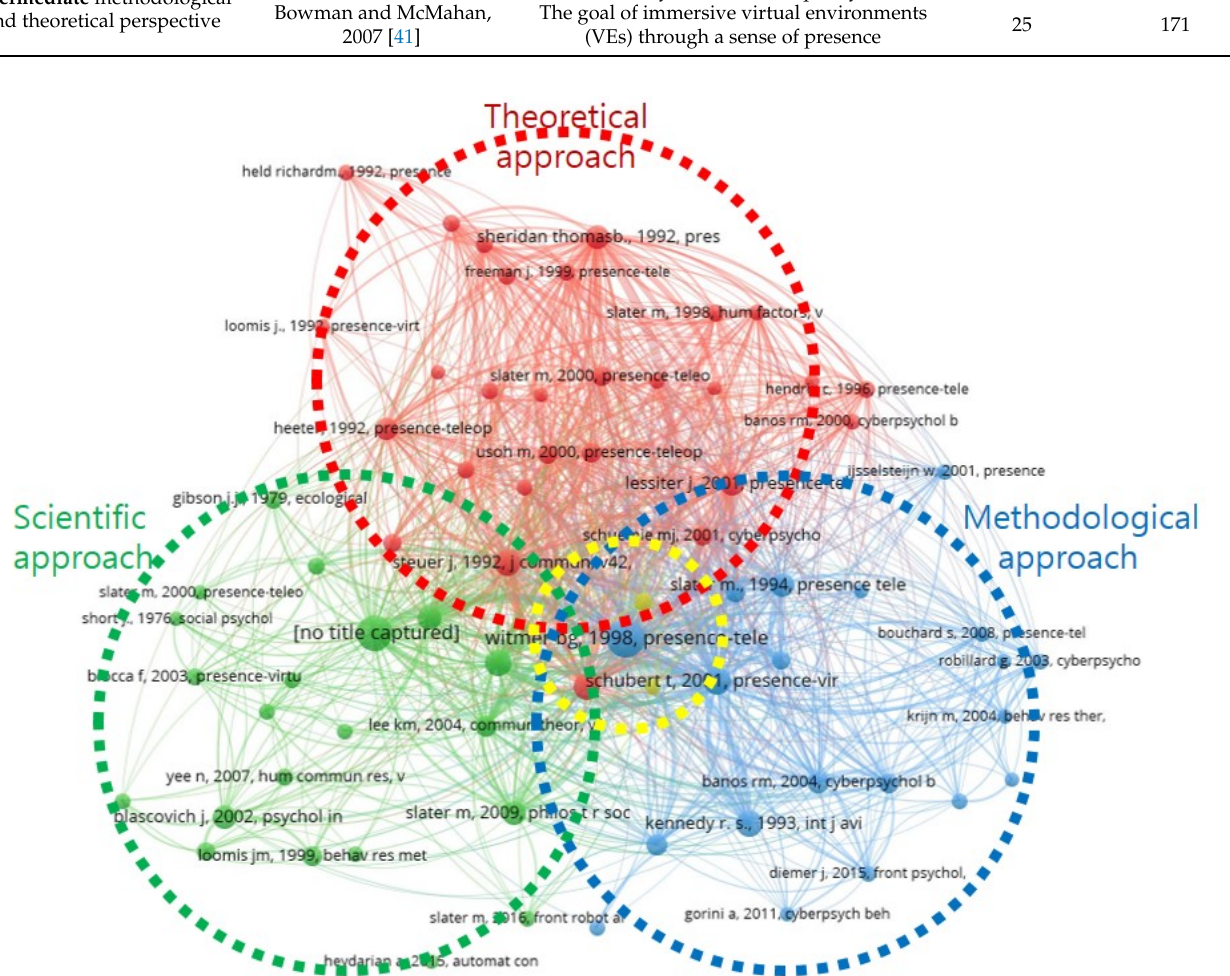
Figure 11. Co-citation analysis map showing foundational themes and seminal publications of clusters (source: Authors). Table 9. Top 12 most co-cited publications identified through co-citation analysis of cited references showing thematic clusters and seminal publications ranked by link strength.